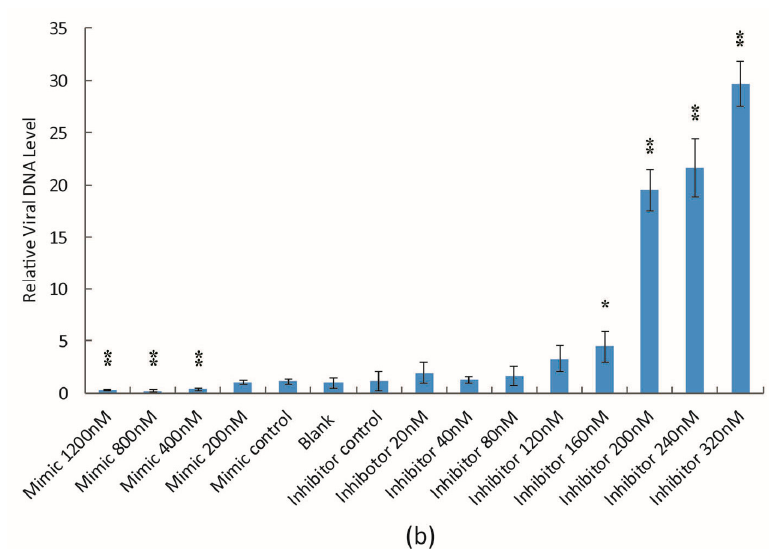
Figure 4. The effect of bantam mimic and inhibitor on viral DNA replication in Sf9 cells. Total DNA